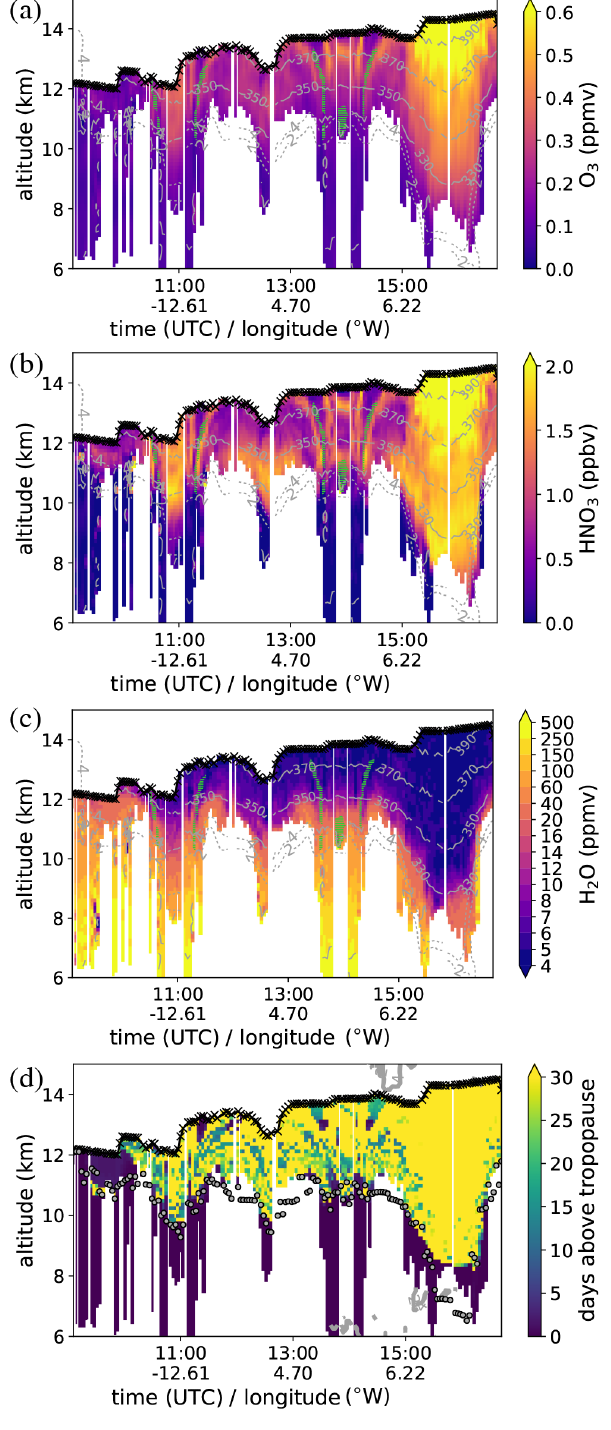
Figure 13. 2-D data from the 9 October flight. Ozone (a) , nitric acid (b) and water vapour (c) retrievals with stratosphere residence time plot (d) for the same air parcels. Isentropes are shown as thin solid lines; 2 and 4PVU contours are shown as thick dashed lines. Green hatches represent air parcels observed by GLORIA on 7 October.